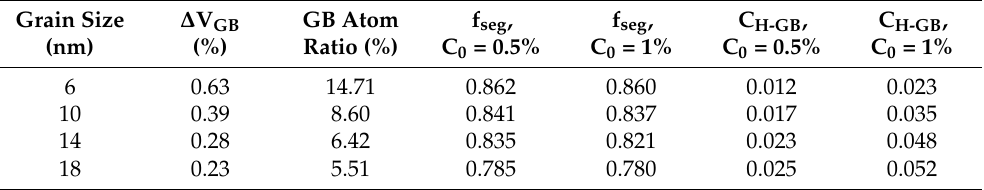
Table 1. GB characters and H segregation properties in NG 6 , NG 10 , NG 14 and NG 18 .